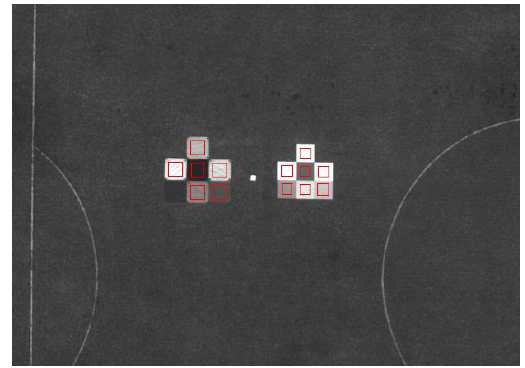
Figure 5. A processing of semi-automatic target detection method.